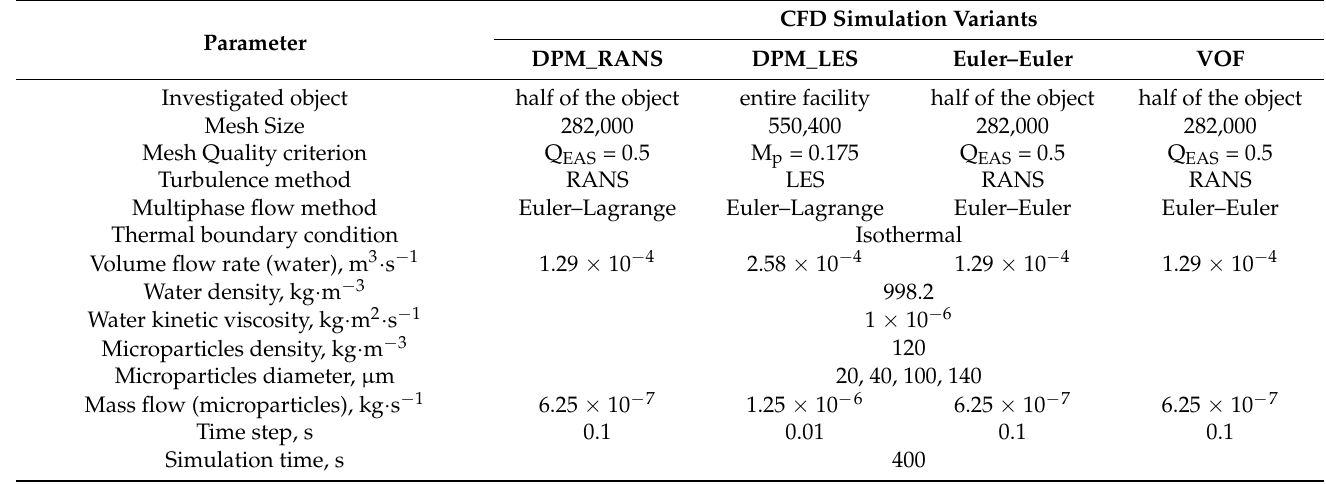
Table 2. Description of parameters used for various simulation